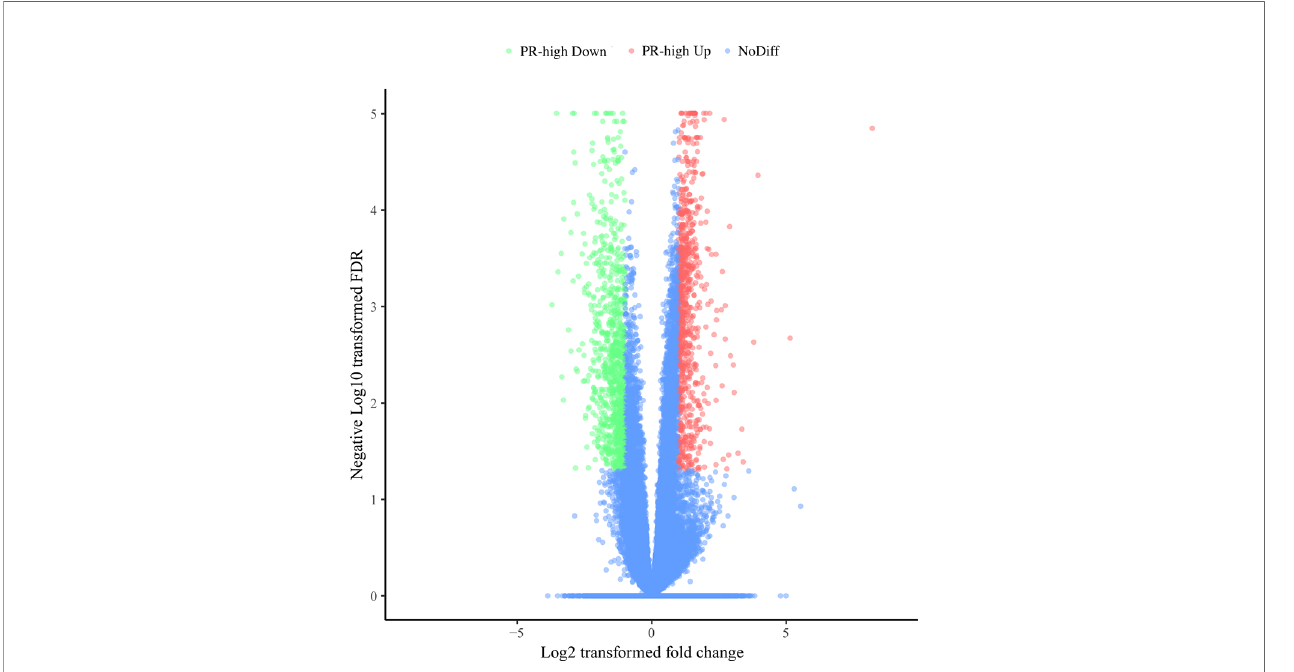
FIGURE 3 | Differentially expressed genes (DEGs) in the neutrophils of dairy cows with low or high milk somatic cell counts at Week 1 prepartum. The x-axis represents the log2-fold change values of DEGs, and the y-axis indicates log10 ( P value). The signi fi cantly up- and downregulated genes are shown as red and green dots, respectively, whereas the blue dots represent genes without signi fi cant expression changes. PR-high, prepartum high